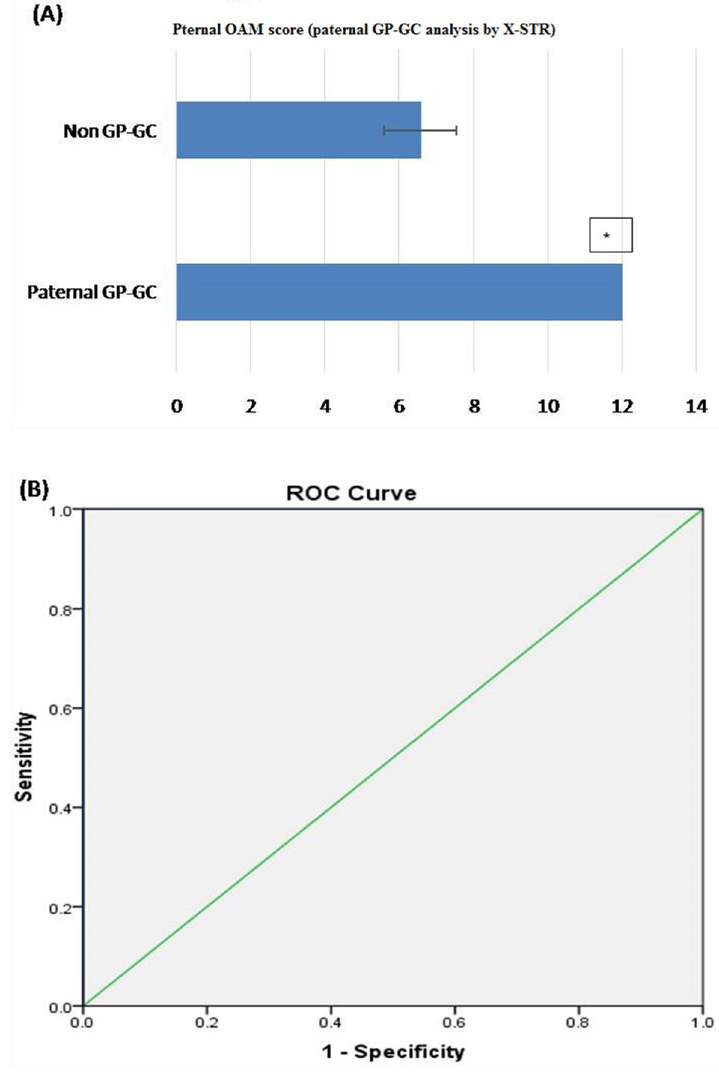
Figure 8. ( A ) OAM score for paternal GP-GC analysis by X-STR: Based on OAM score, statistically significant difference between paternal GP-GC (related) and non-GP-GC (unrelated) groups was seen with X-STR. The average OAM score for GP-GC is 12 ± 0.00 (SD), whereas, for the non-GP-GC group, the average OAM is 6.57 ± 0.976 (SD). Figure 8 (A & B) obtained from SPSSsoftware version 22.0 (Available for download at: https:// www. ibm. com/ suppo rt/ pages/ downl oading- ibm- spss- stati stics- 22). *Statistically significant difference (p < 0.05). ( B ) ROC curve (AUC of 100%), showing the performance of OAM score as a screening test for Paternal GP-GC pairs by X-STR.